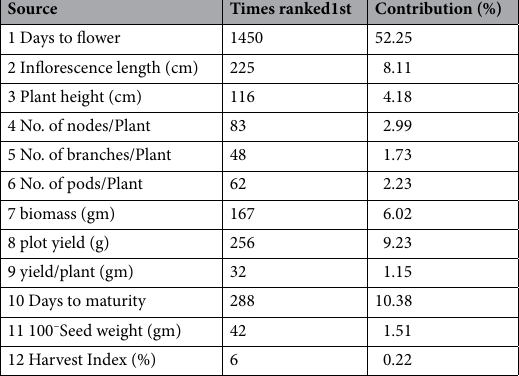
Table 3. Relative contribution of twelve different characters to total genetic diversity.